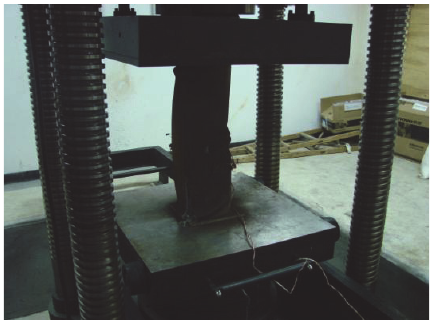
Figure 4: Load-bearing capacity test of the CFST column.